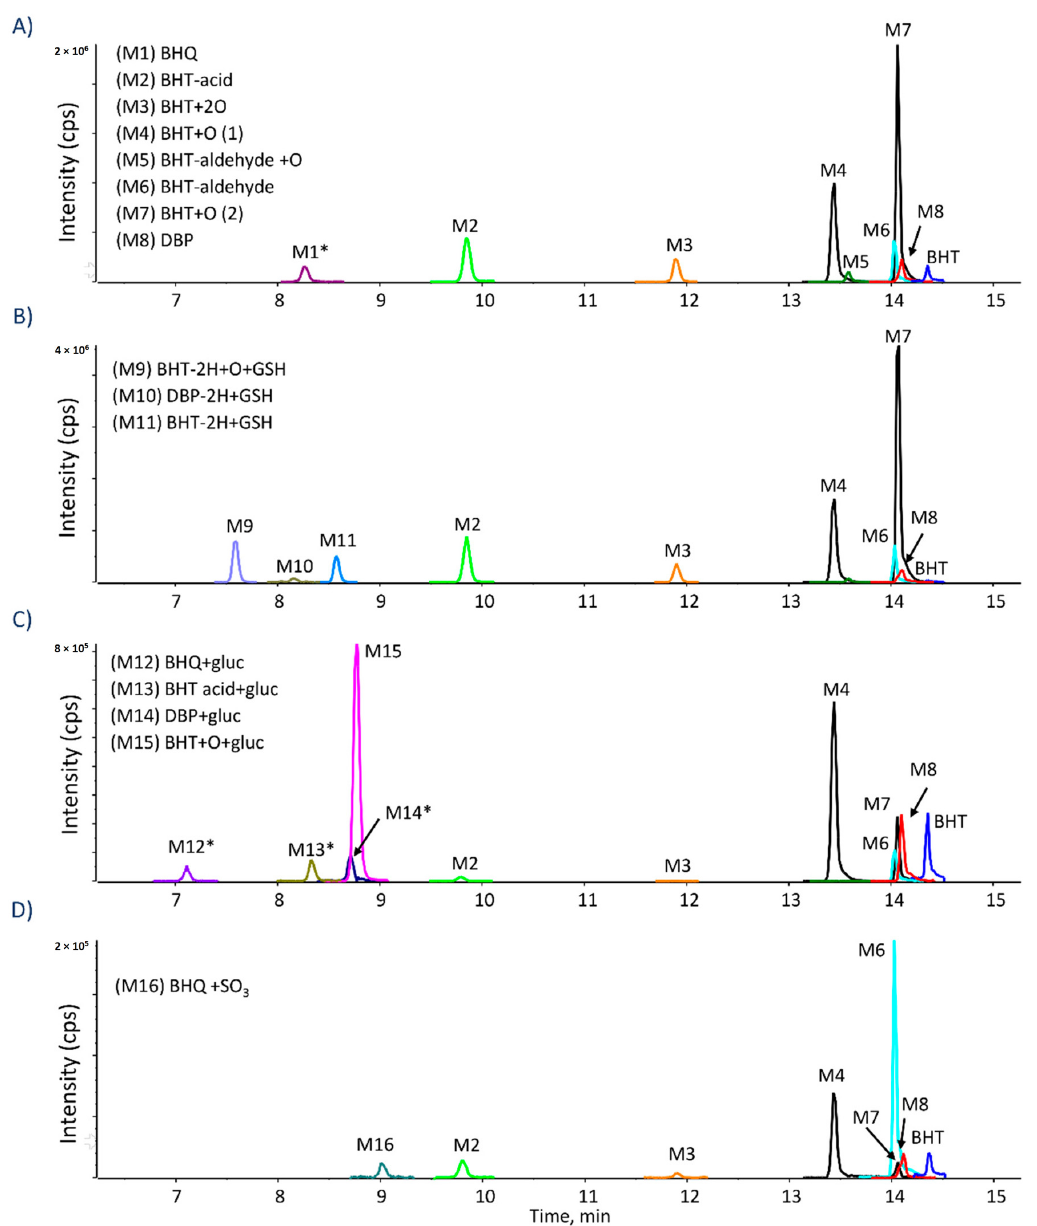
Figure 2. Extracted ion chromatograms of BHT metabolites formed in ( A ) HLM with NADPH; ( B ) HLM with NADPH and GSH; ( C ) HLM with NADPH and UDPGA; ( D ) Human S9 fraction with NADPH and PAPS; Peaks with asterisk. * were increased by 10×.